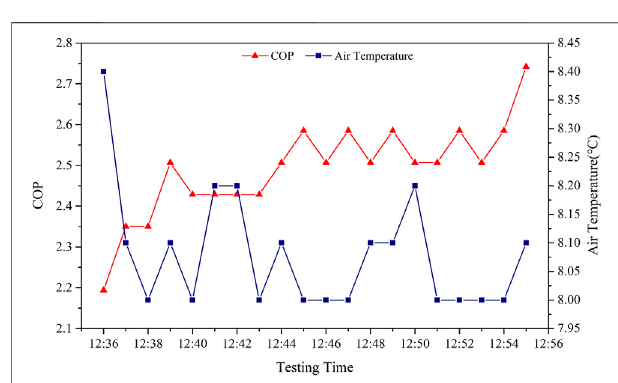
FIGURE 8 | The COP and outdoor air temperature in condition 3.